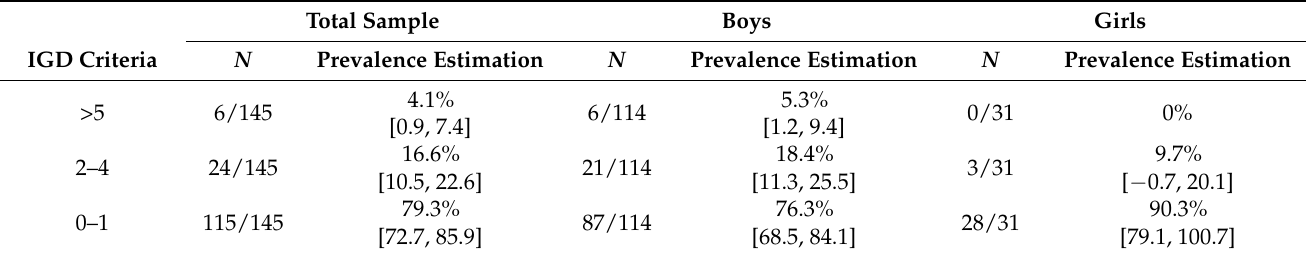
Table 3. Estimated IGD prevalence in 5- to 10-year-old patients in outpatient psychotherapy assessed via parental report. Total